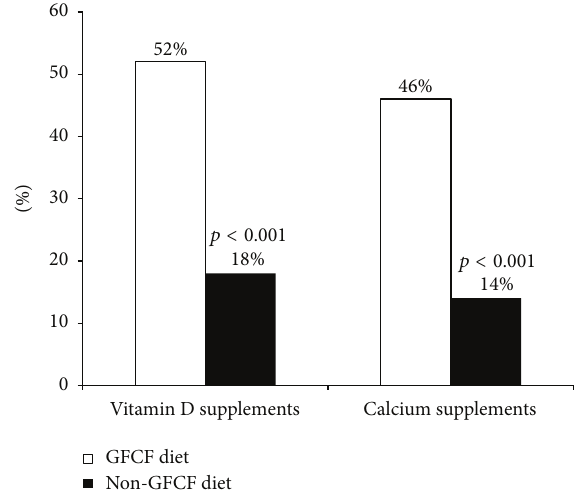
Figure 1: Percentage of children on the GFCF diet versus the non- GFCF diet taking vitamin D and calcium supplements.